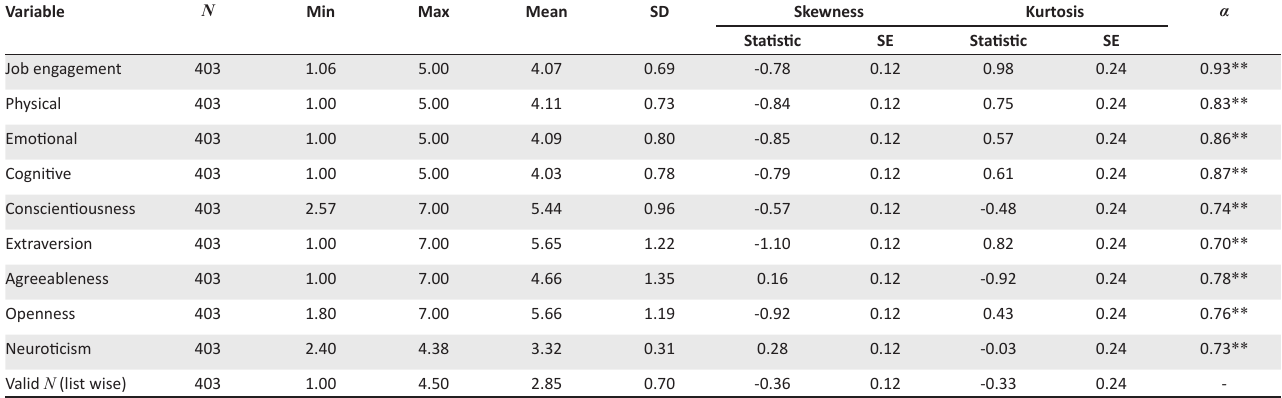
TABLE 1: Descriptive statistics and reliability statistics of the scales. Variable